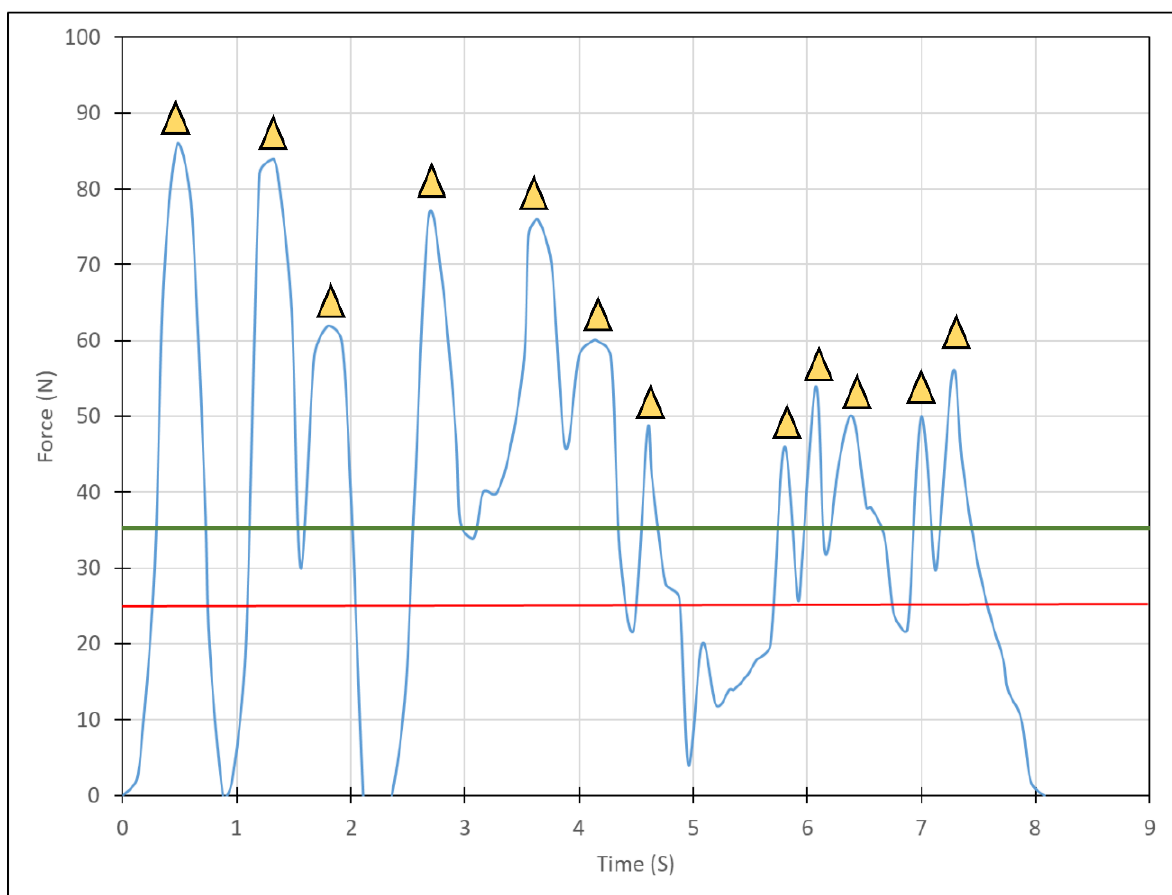
Figure 2. A characteristic force-time diagram acquired during restoration placement. The yellow triangles represent the local peak forces during the procedure where the peaks were considered as above the minimum values of 25 Newtons (red solid line). The mean force expressed by the practitioner during restorative material placement is also presented (green solid line).